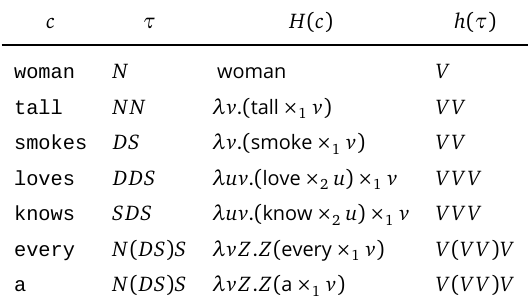
Term homomorphic images H ( c ) for pointwise addition and multiplication, and matrix multiplication as composition